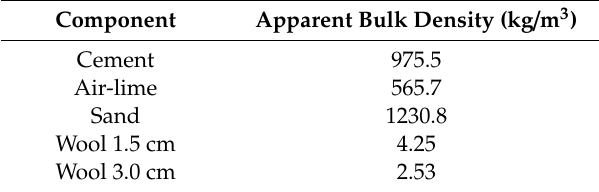
Table 1. Apparent bulk density of the constituents.